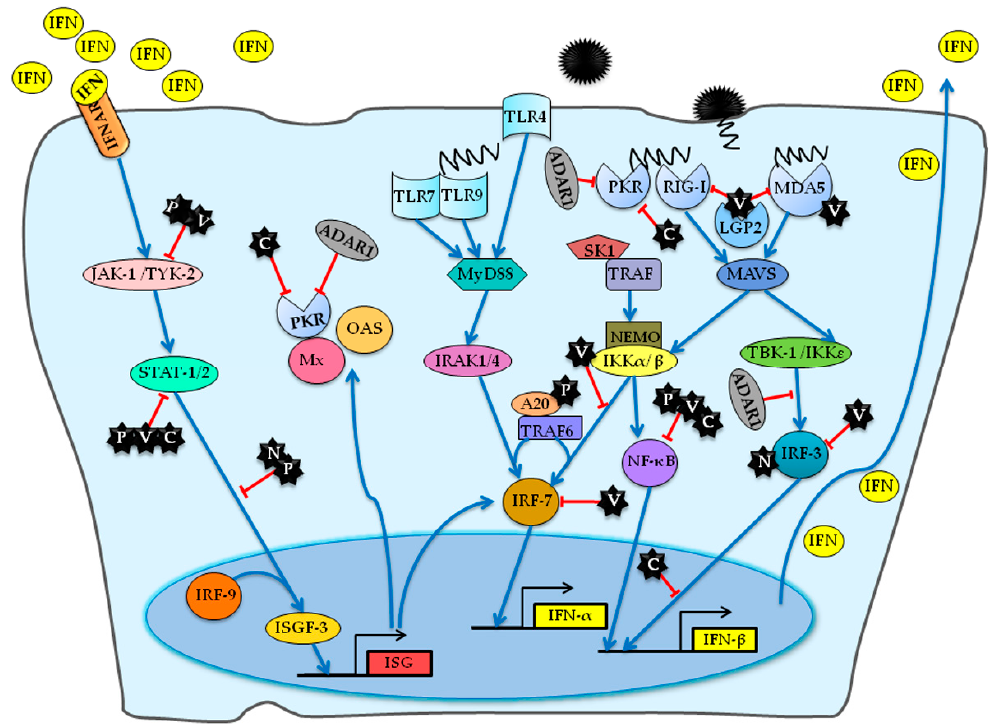
Figure 2. A detailed overview of host factors involved in MeV-stimulated interferon (IFN) induction and signaling. The C and V proteins inhibit the activation of the viral RNA sensors retinoic-acid inducible gene I (RIG-I), melanoma differentiation-associated protein 5 (MDA5) and RIG-I-like receptor 2 (LGP2) and the following IFN responses. Furthermore, V protein inhibits the activation and function of interferon regulatory transcription factor 3 (IRF-3) and IRF-7 via interaction with them. The P, V, and C proteins bind subunits of nuclear factor-kappa B (NF- κ B) and repress the production of IFN- β and cytokine. In addition, the interaction between P protein and the negative regulator A20 also leads to the repression of NF- κ B. In addition, sphingosine kinase 1 (SK1) interacts with TNF receptor-associated factor 2 (TRAF2) and enhances tumor necrosis factor (TNF)-induced activation of NF- κ B signaling. In the nucleus, C protein represses IFN- β transcription without inhibiting the activation of IRF-3. On the contrary, N protein positively activates the IRF-3 and IFN- β production. The interferon inducible protein ADAR1 negatively regulates the activation of protein kinase regulated by RNA (PKR) and the IRF-3, suppressing MeV-mediated IFN- β production. To interfere with the IFN signaling, C protein blocks the dimerization of phosphorylated signal transducer and activator of transcription 1 (STAT-1). P and V protein inhibit the phosphorylation and nuclear translocation of STAT-1. In addition, N protein can prevent the migration of STAT-1 and STAT-2 into nucleus. The IFN signaling triggers the expression of many IFN-inducible proteins. The arrows indicate the activation of IFN responses while the T-ended arrows indicate the repression by MeV. JAK-1, Janus kinase 1; TYK-2, tyrosine kinase 2; ISG IFN-stimulated gene; IRF, interferon regulatory factor; IKK, I κ B kinase; TLR, Toll-like receptor; ADAR1, adenosine deaminase acting on RNA 1; MAVS, mitochondrial antiviral-signaling protein; OAS, 2 (cid:48) -5 (cid:48) -oligoadenylate synthetase; IRAK, interleukin-1 receptor-associated kinase